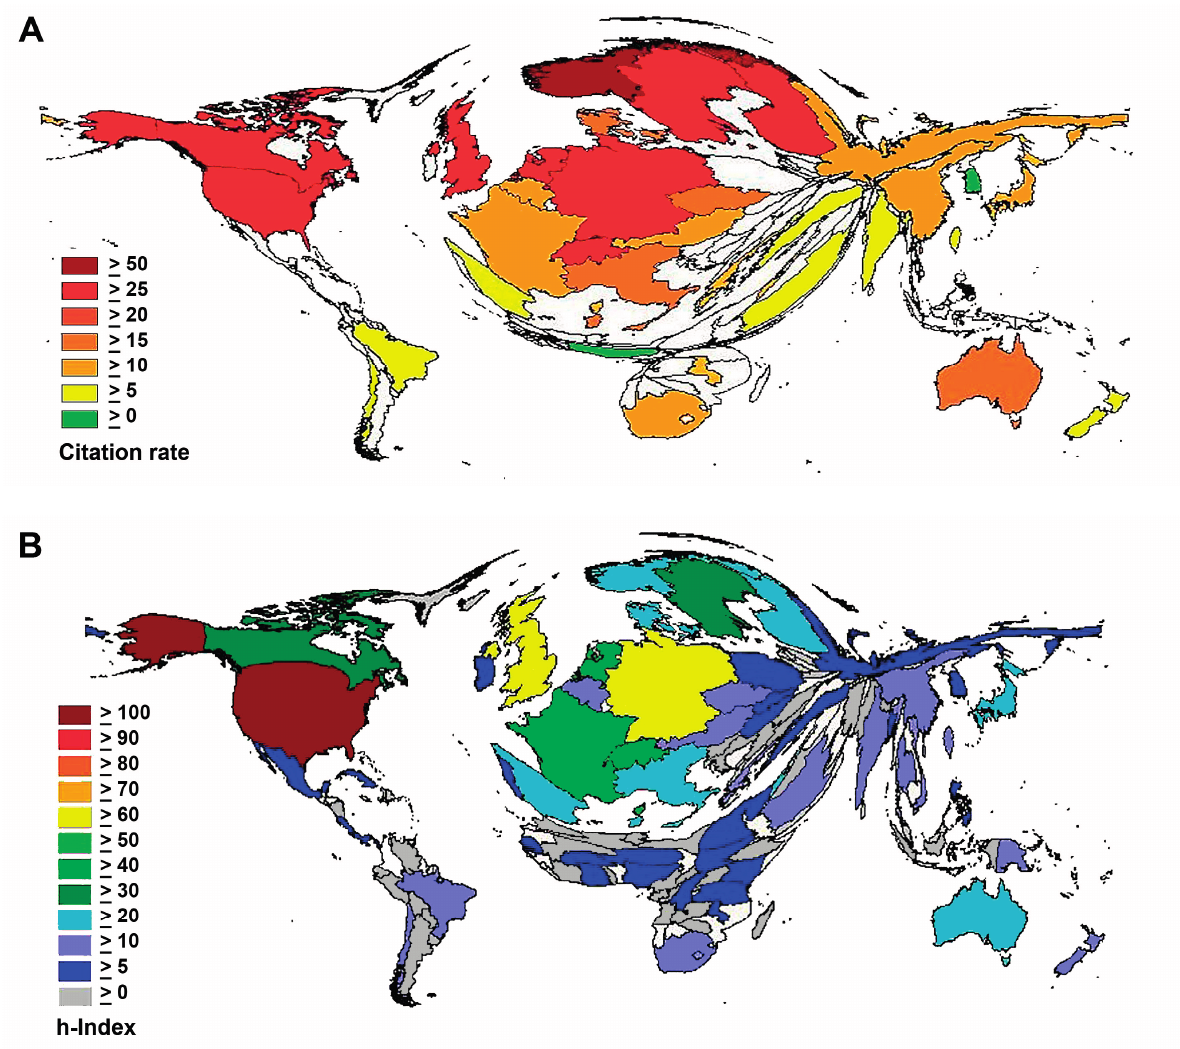
Figure 2. Citation parameters. ( A ) Density-equalizing map illustrating average citation rate. Colors encode average citation rates. ( B ) Density-equalizing map illustrating international h-indices (Hirsch-factor). Colors encode h-index